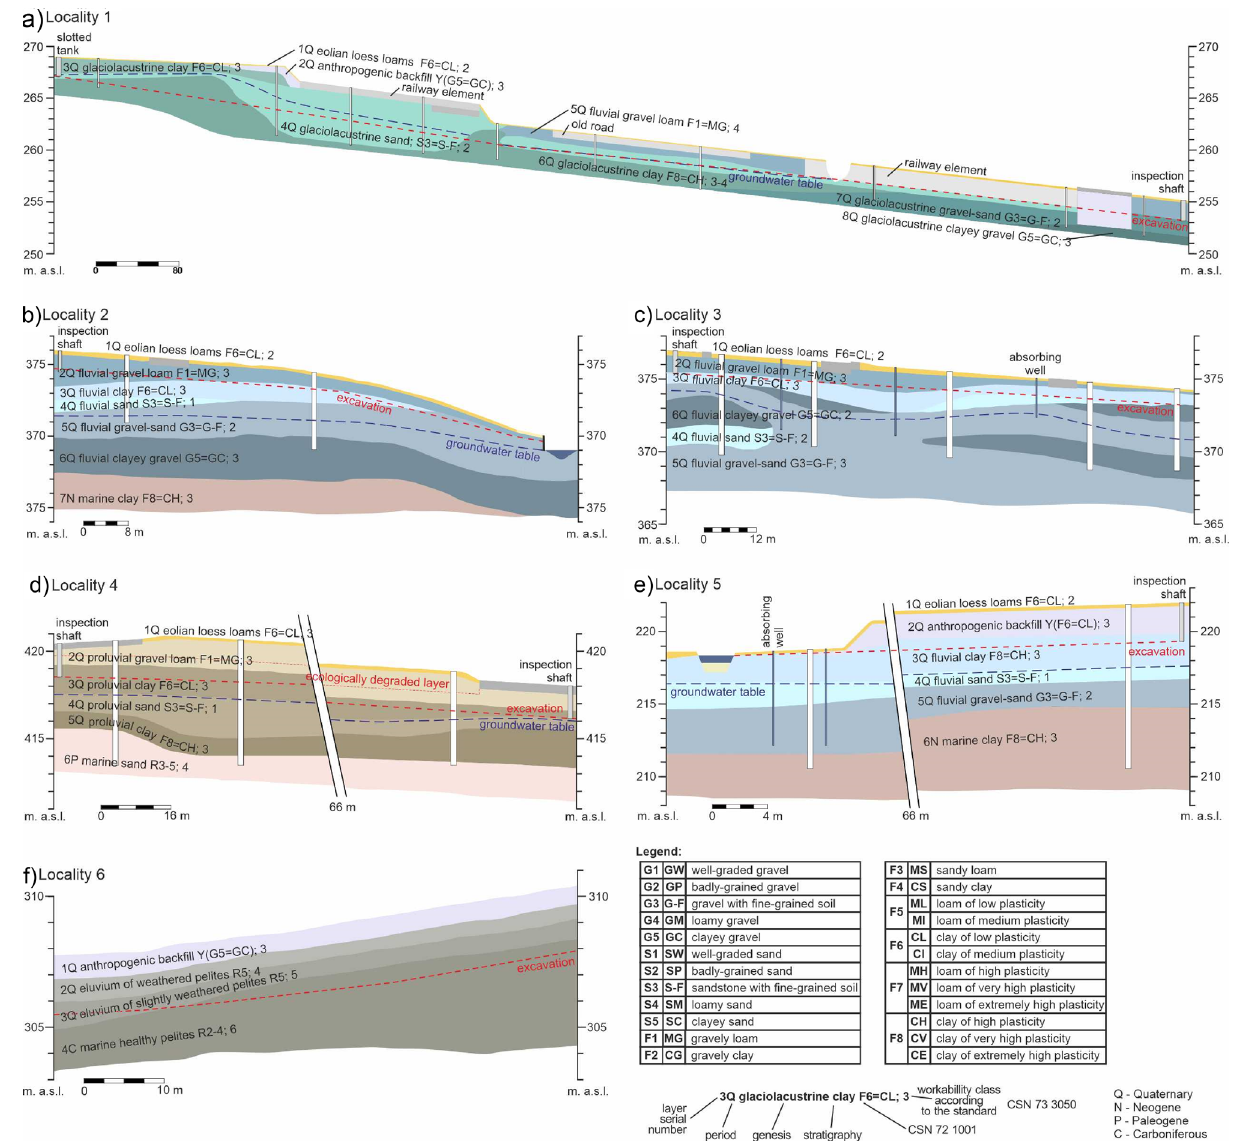
2019 software www. corel draw.